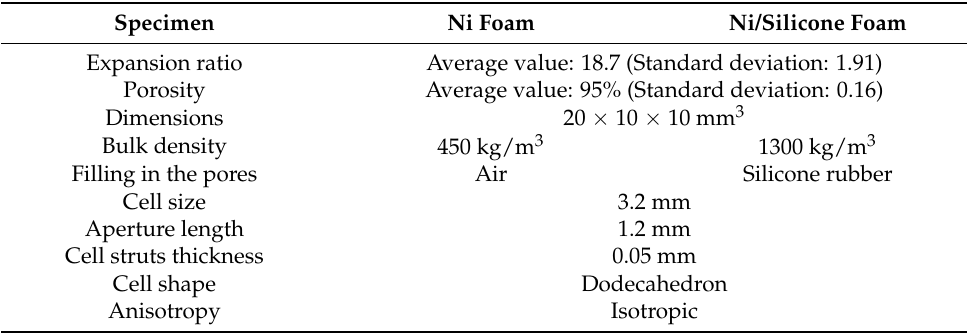
Figure 2. 3D image of typical Ni foam. Table 1. Cell shape parameters of Ni foam and Ni/silicone foam.